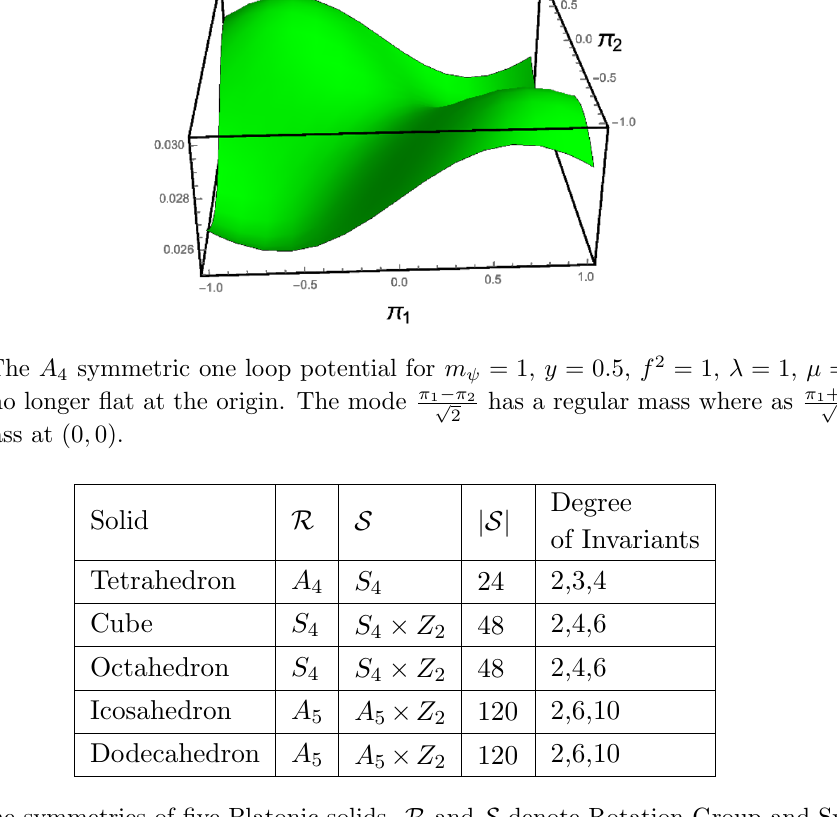
and denote Rotation Group and Symmetry R S is the discrete group representing the symmetries of the R is the double cover. denotes the number of elements in the symme- S jSj